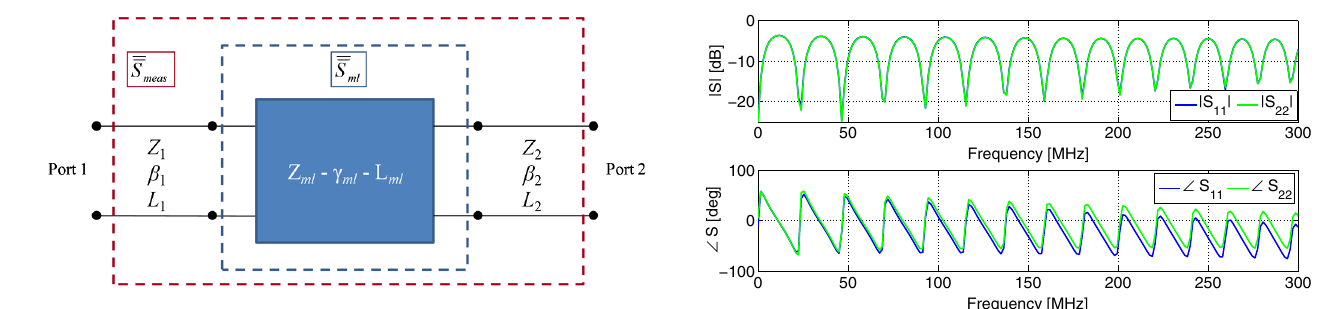
FIG. 4. Scheme of the measurement setup for the meander line. FIG. 6. Modulus and phase of S 11 meas and S 22 meas .